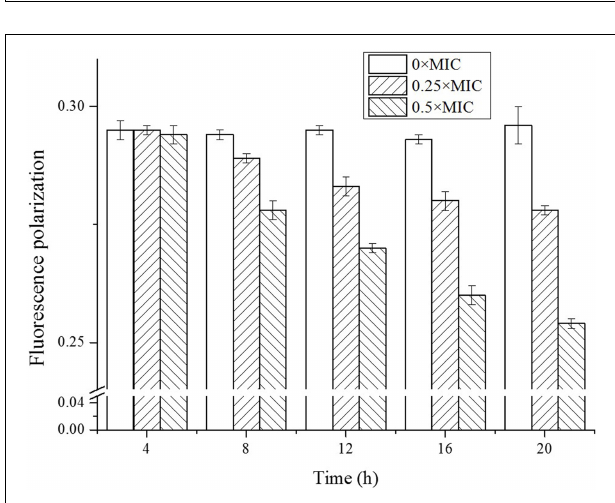
FIGURE 7 | Detection of fluidity of Salmonella cell membrane treated by different doses of